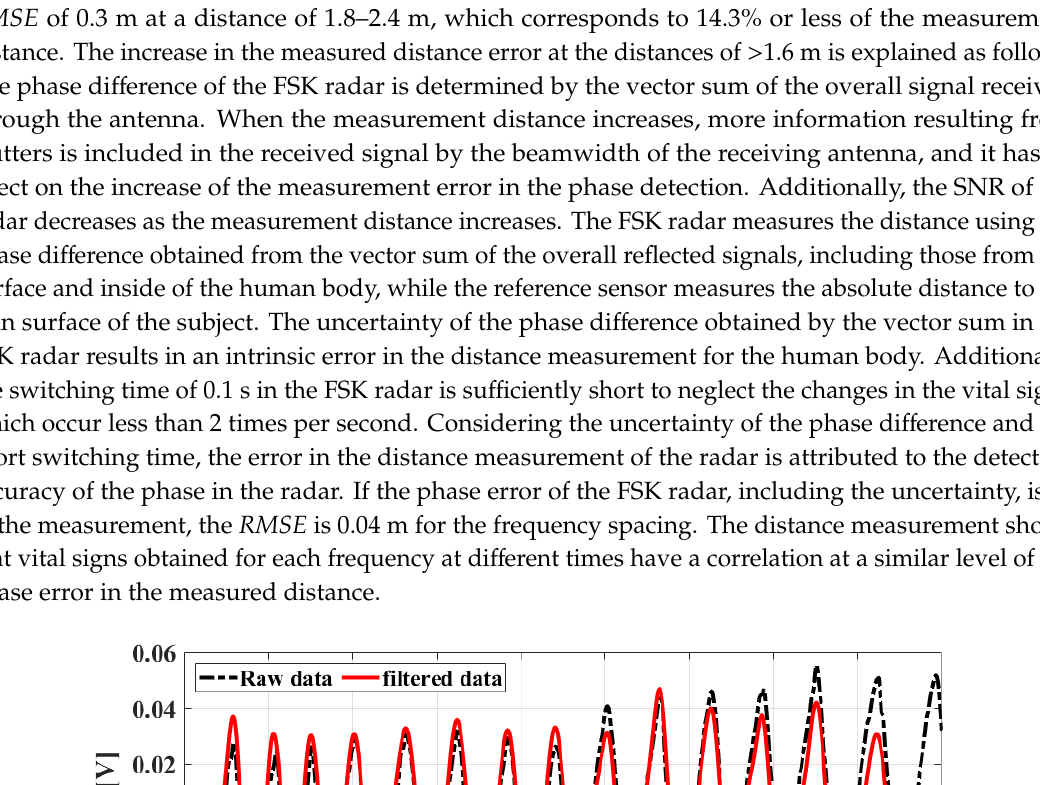
Figure 8. Measurement setup for detecting the distance and vital signs using the proposed FSK radar. Table 1. Information relevant to the subjects.